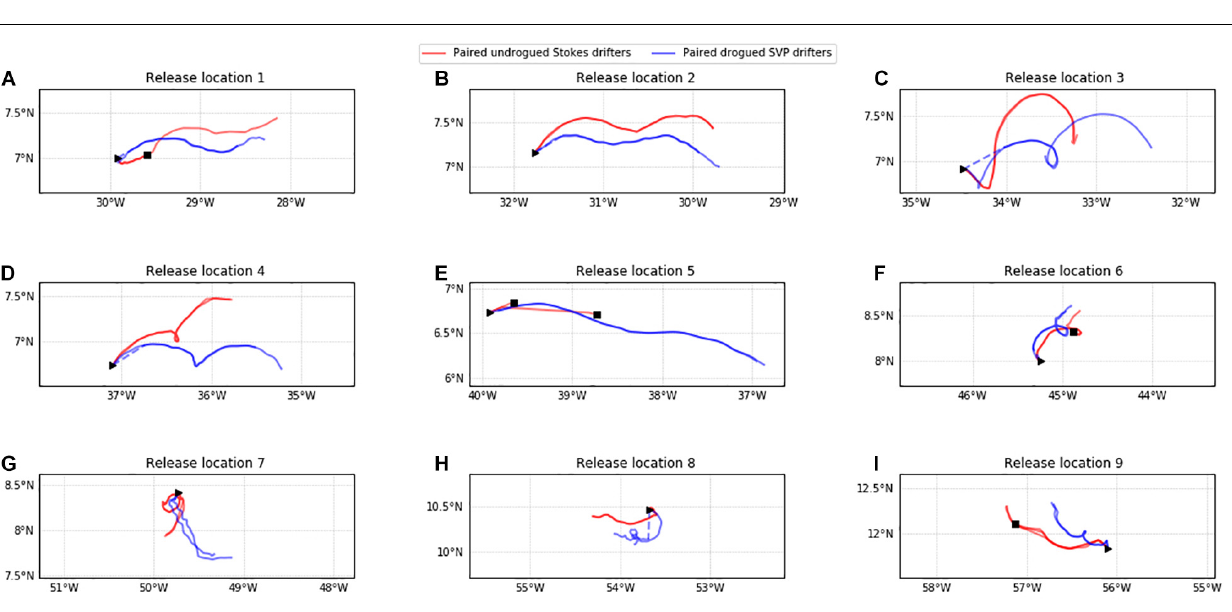
Frontiers in Marine Science |